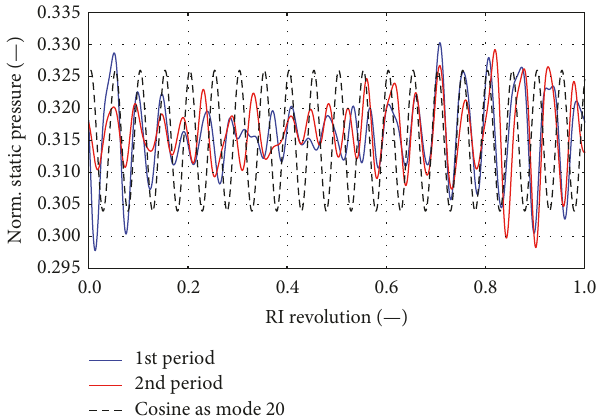
Figure 9: Two successive RI revolutions of the rotating instability in the casing pressure signal from above the rotor 1 LE (low-pass filtered at 5kHz, below BPF, colored lines), and cosine as reference (black dashed line).